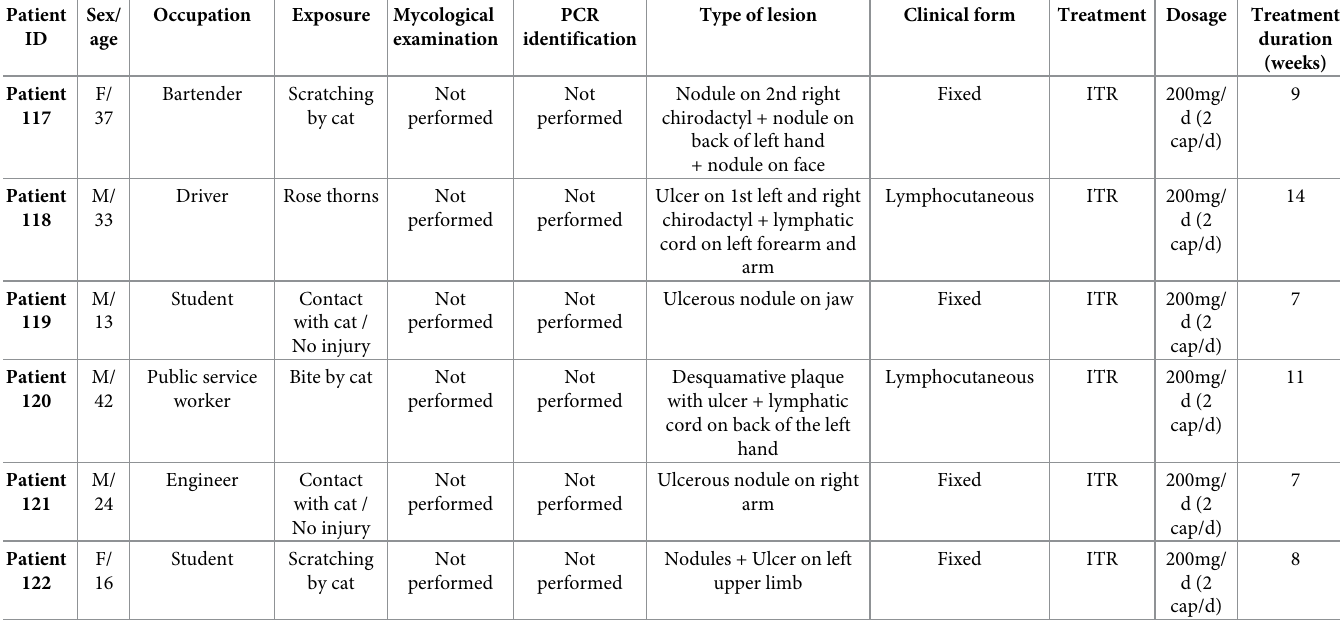
resulting from multiple cat bites on each mentioned body site: right and left arm and right calf. Patient 61 only presented polymorphic erythema, but no sporotrichoid lesions; patient 84 only had a scar on her left thigh, meaning that the lesion had started to heal after previous treatment (fixed cutaneous form). Altogether, they compose a population of 122 individuals (Table 1 and Fig